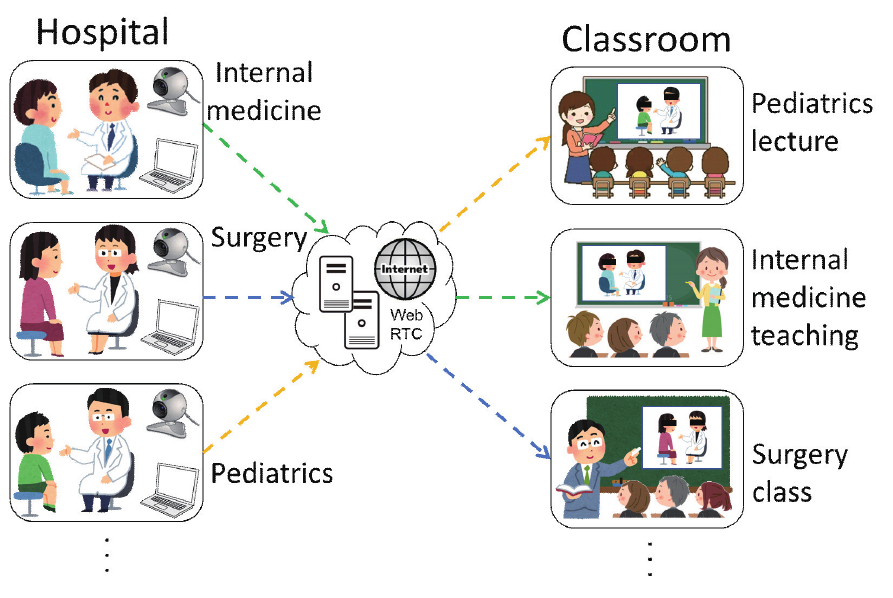
Figure 1. A vision of secure streaming